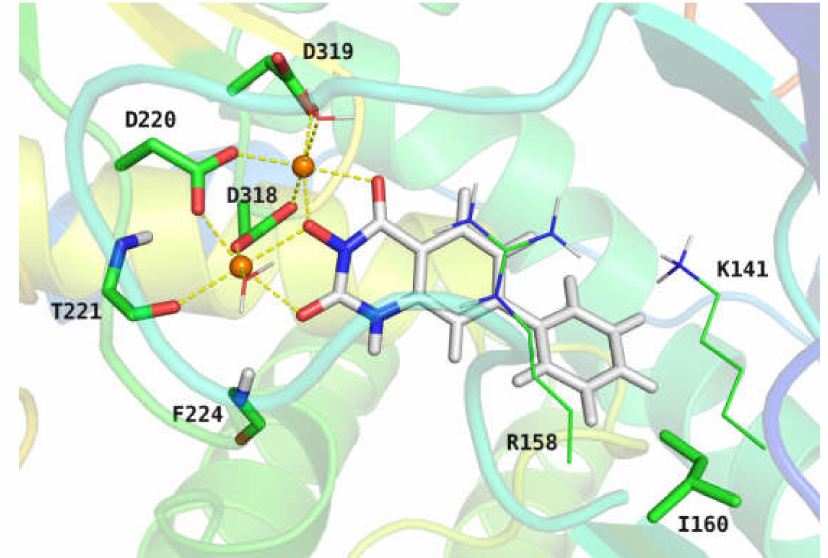
Figure 4. Binding model of compound 21e with NS5B protein from molecular docking study. The central two Mg 2+ ions are shown in orange spheres. The ligand molecule is shown in sticks with carbon atoms and hydrogen atoms colored grey. The key amino acid residues and two water molecules in the catalytic center are presented in sticks or lines with non-polar hydrogen atoms hidden for clarity. The chelation interactions of Mg 2+ with the ligand, water molecules, and central amino acid residues are shown in golden dash